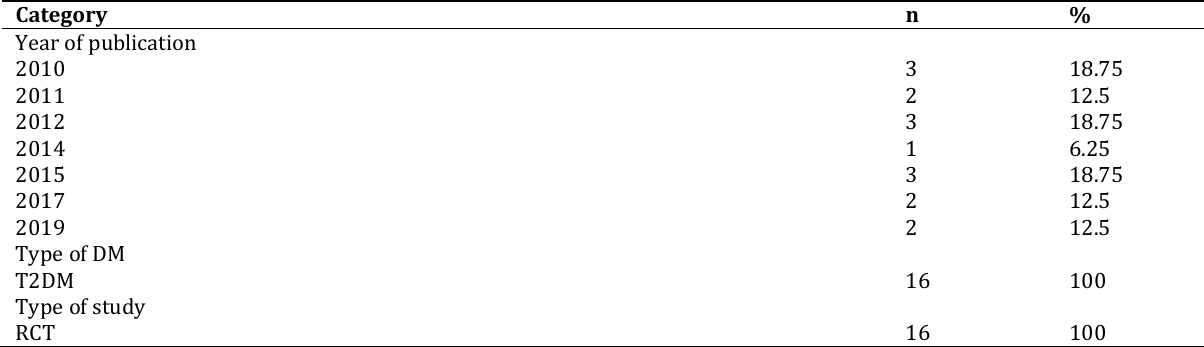
Table 1. Characteristics of the